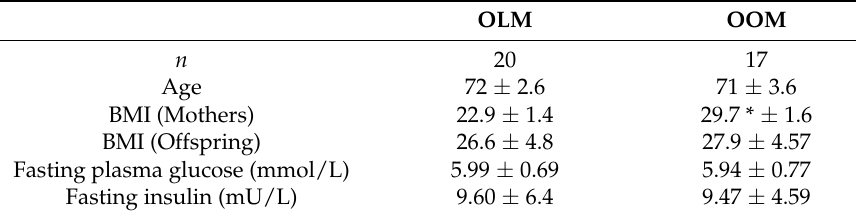
Table 1. Characteristics of study participants and of their mothers.